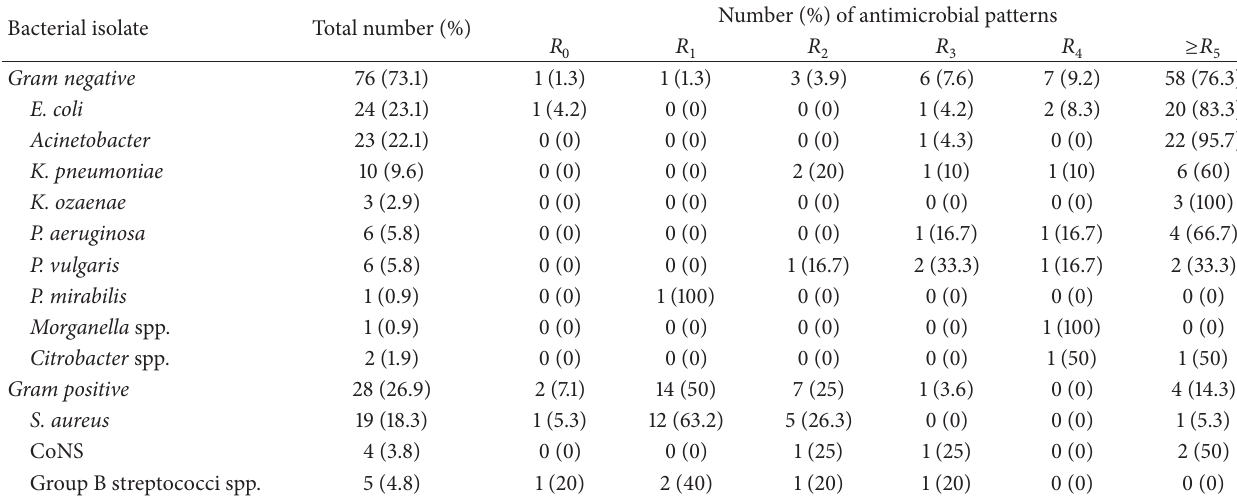
Table 6: Multidrug resistance pattern of bacterial